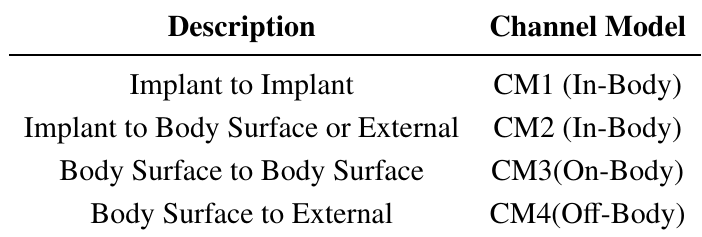
Table 1. Channel models in body area network (BAN). CM, channel model.